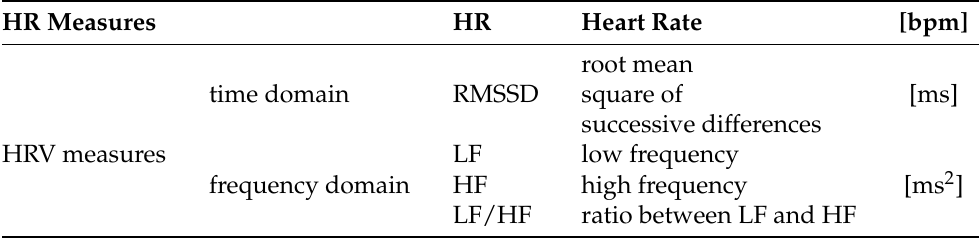
Table 2. Dependent